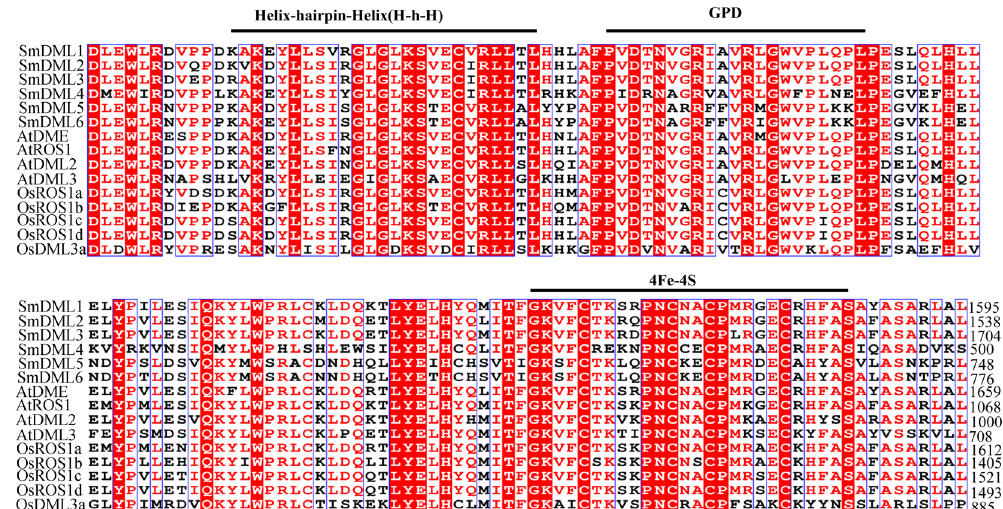
Figure 2. Amino acid sequence alignment of the conserved DNA glycosylase domain of DML proteins in S . miltiorrhiza , Arabidopsis and rice. Numbers show the position of amino acids. Identical amino acids are highlighted in red. Similar amino acid residues are showed in red.